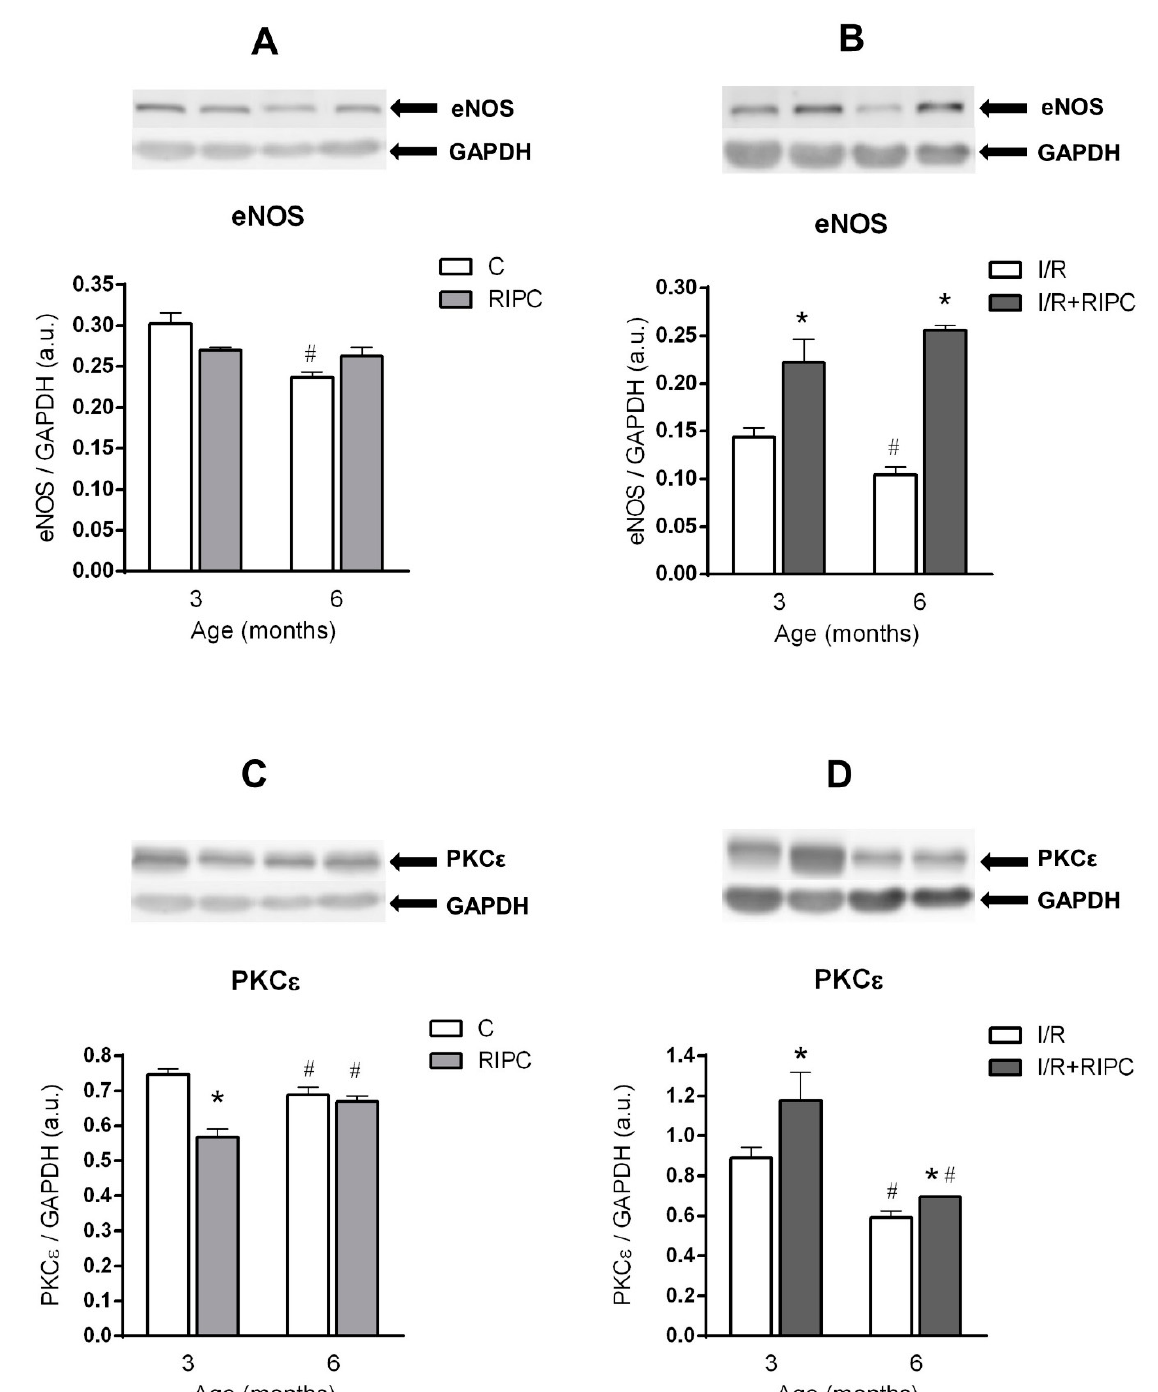
Figure 3. The effect of age and remote ischemic preconditioning on the expression of selected signaling pathway proteins in rat myocardium at the baseline conditions ( A , C ) and after ischemia/reperfusion ( B , D ). Samples were taken prior to ischemia (after 20 min stabilization perfusion) and at 40 min of post-ischemic reperfusion. eNOS—endothelial nitric oxide synthase, expressed in arbitrary units (a.u.). PKC ε —protein kinase C epsilon, expressed in arbitrary units (a.u.). ( A , B )—expression of eNOS, ( C , D )—expression of PKC ε . ( C )—baseline samples, I/R—post-IR samples, RIPC—samples with prior remote ischemic preconditioning. Data are presented as means ± S.E.M of 4–5 hearts per group, normalized to the levels of GAPDH. * p < 0.05 RIPC vs. C; # p < 0.05 vs. 3